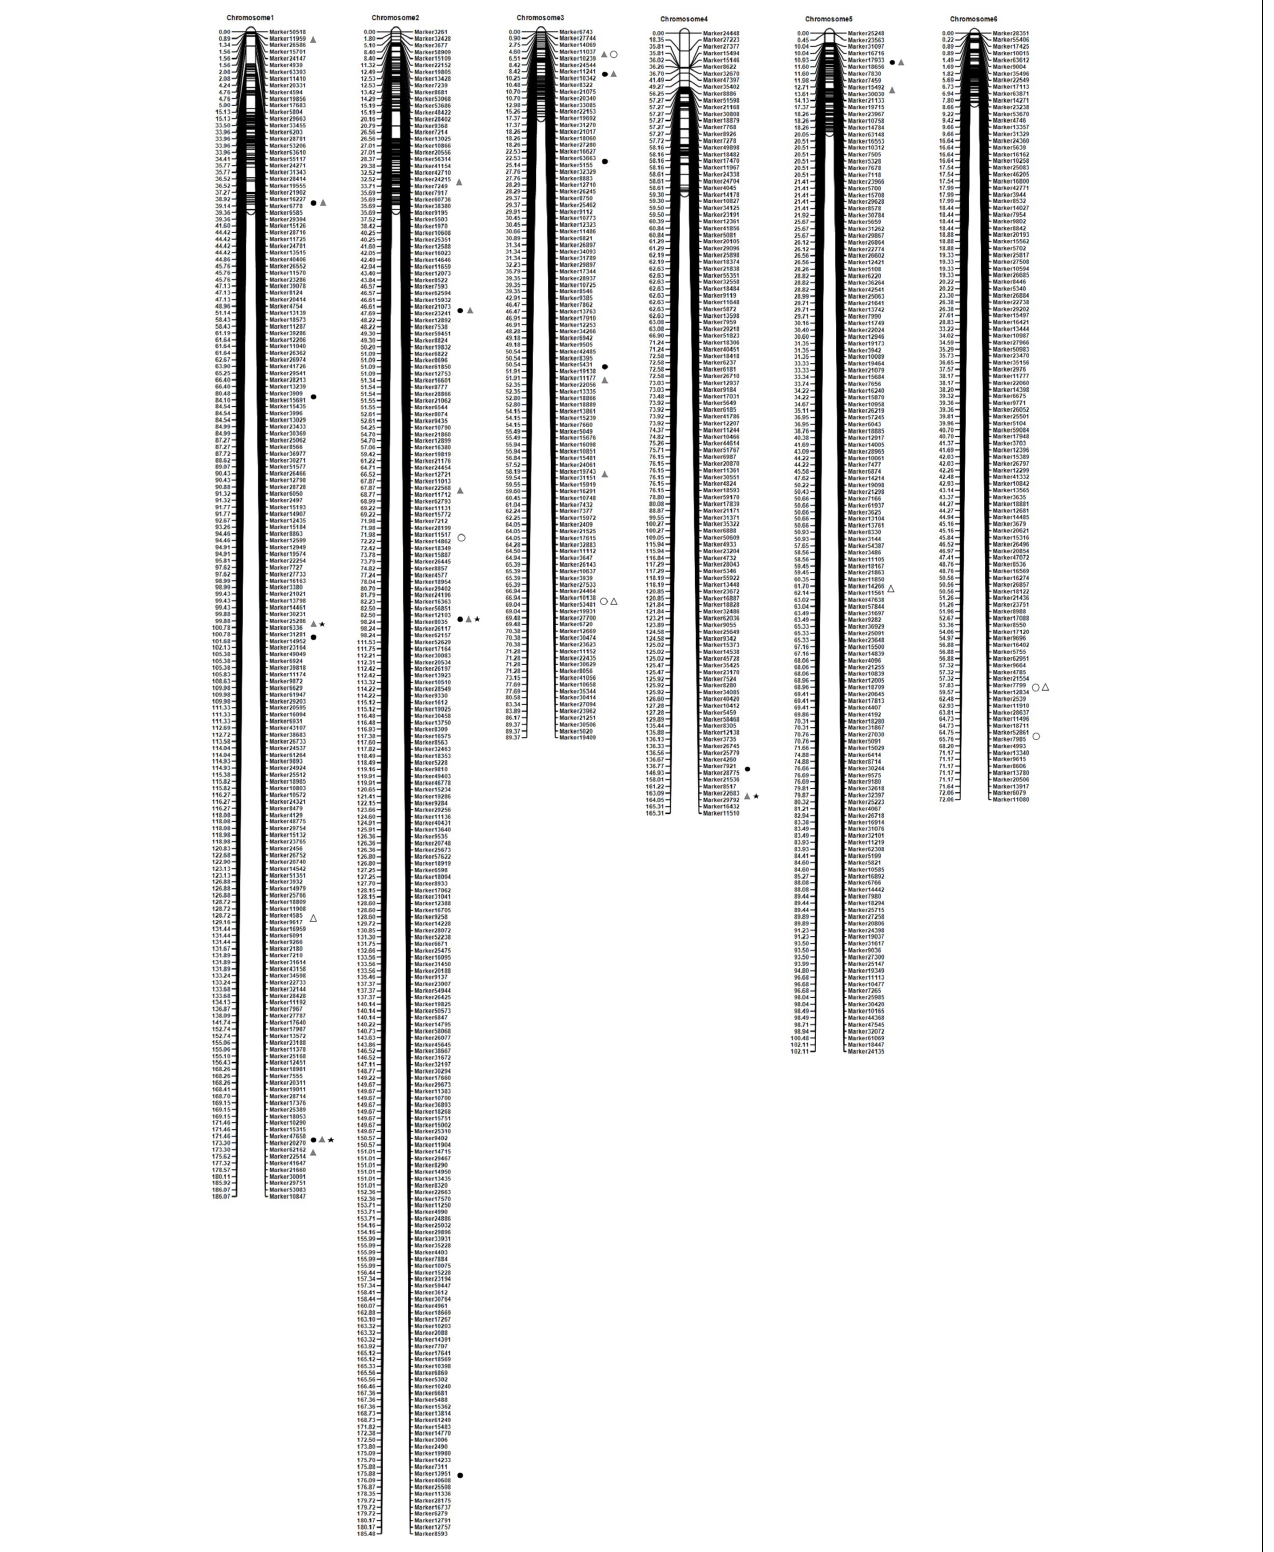
, major unconditional (cid:32)